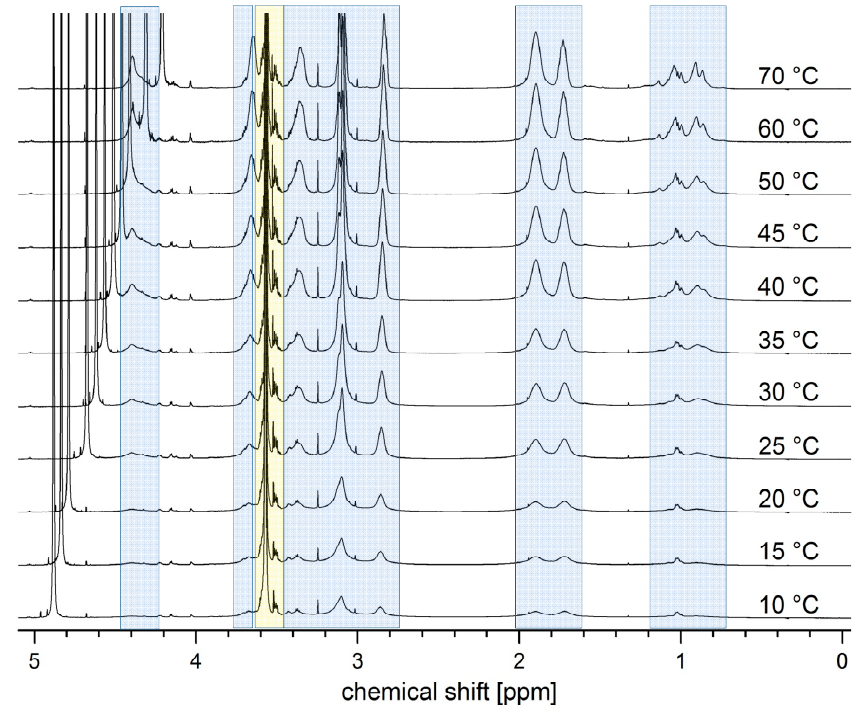
Figure 6. Temperature dependent 1 H NMR spectra of PEG- b -PSBE-1 in D 2 O.